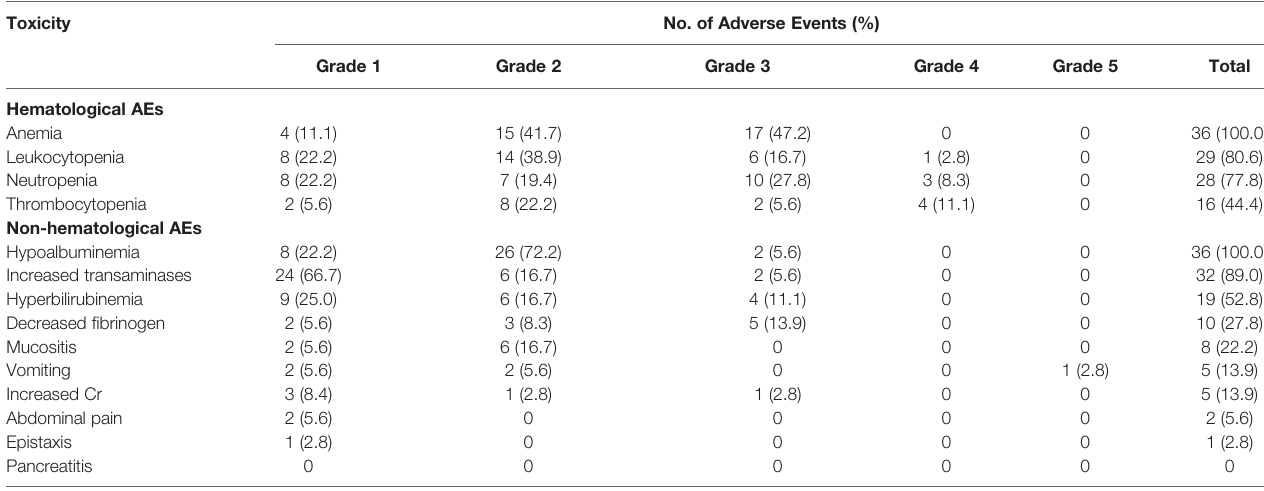
TABLE 2 | Toxicity pro fi les from the GAD-M regimen. Toxicity No. of Adverse Events